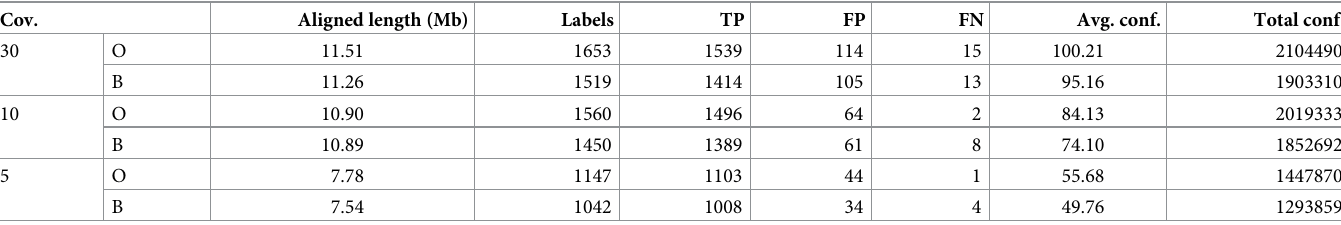
Table 1. BNG assembly pipeline results using both OptiScan (O) and BNG (B) molecules of yeast.